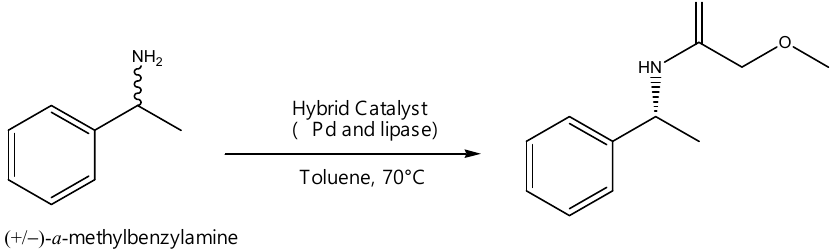
Figure 15. Example of DKR reaction using hybrid Pd-lipase system [111].